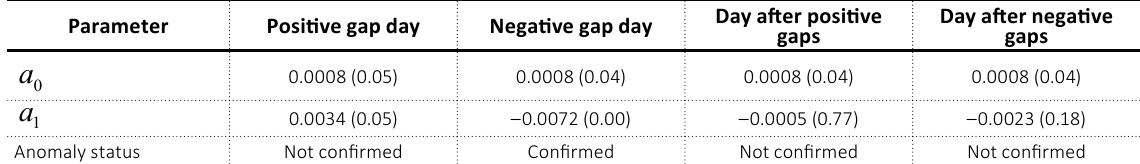
Table A5. Regression analysis with dummy variables, the case of the UX index over the period